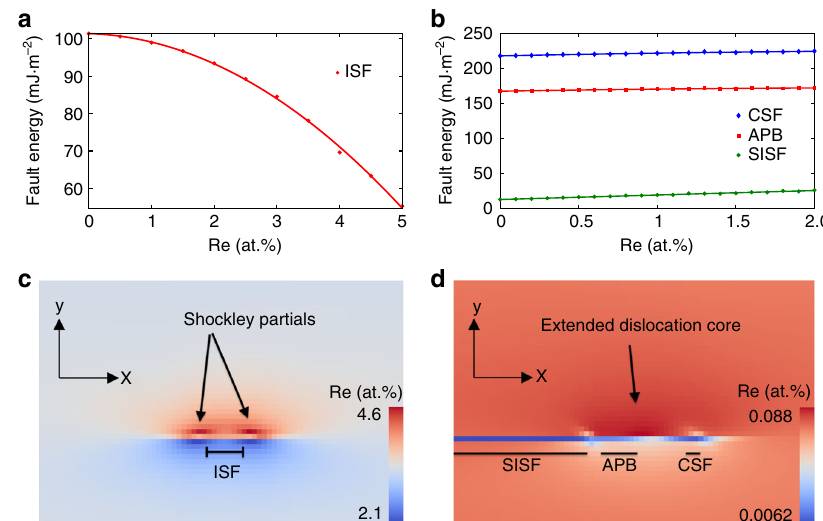
Fig. 7 Phase- fi eld calculation of fault energies and segregation pro fi les. Fault energies in γ ( a ) and γ ′ ( b ) as a function of Re concentration calculated using the interatomic potential in ref. 45 . Point data and solid lines represent the atomistic results and the fi tted model used in PF, respectively. Re concentration fi eld around a dissociated edge dislocation in γ ( c ) and γ ′ ( d ). The dislocation glide plane normal is along y and Burgers vector direction is along x . The initial uniform Re concentration was set to 3.293 and 0.074 at% in γ and γ ′ , respectively.